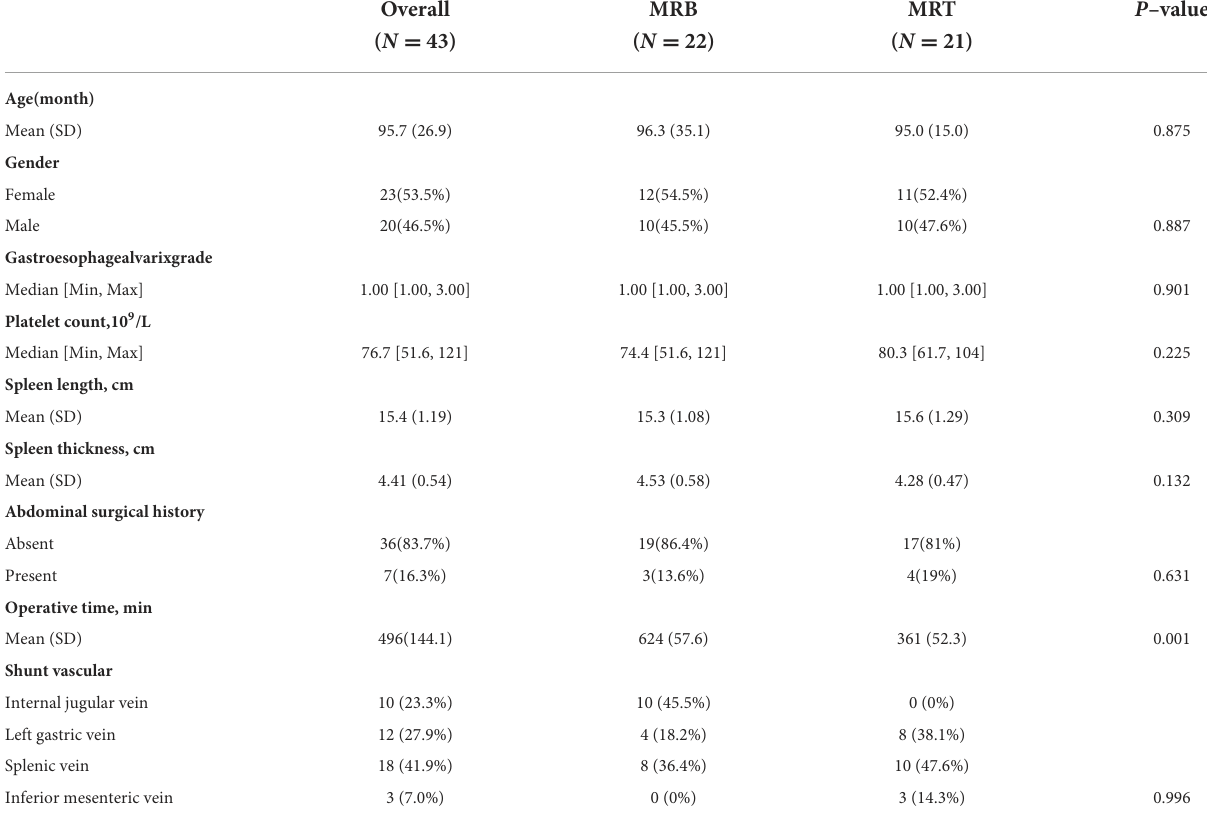
TABLE 1 Baseline characteristics for children with Cavernous transformation of the portal vein (CTPV). Overall MRB